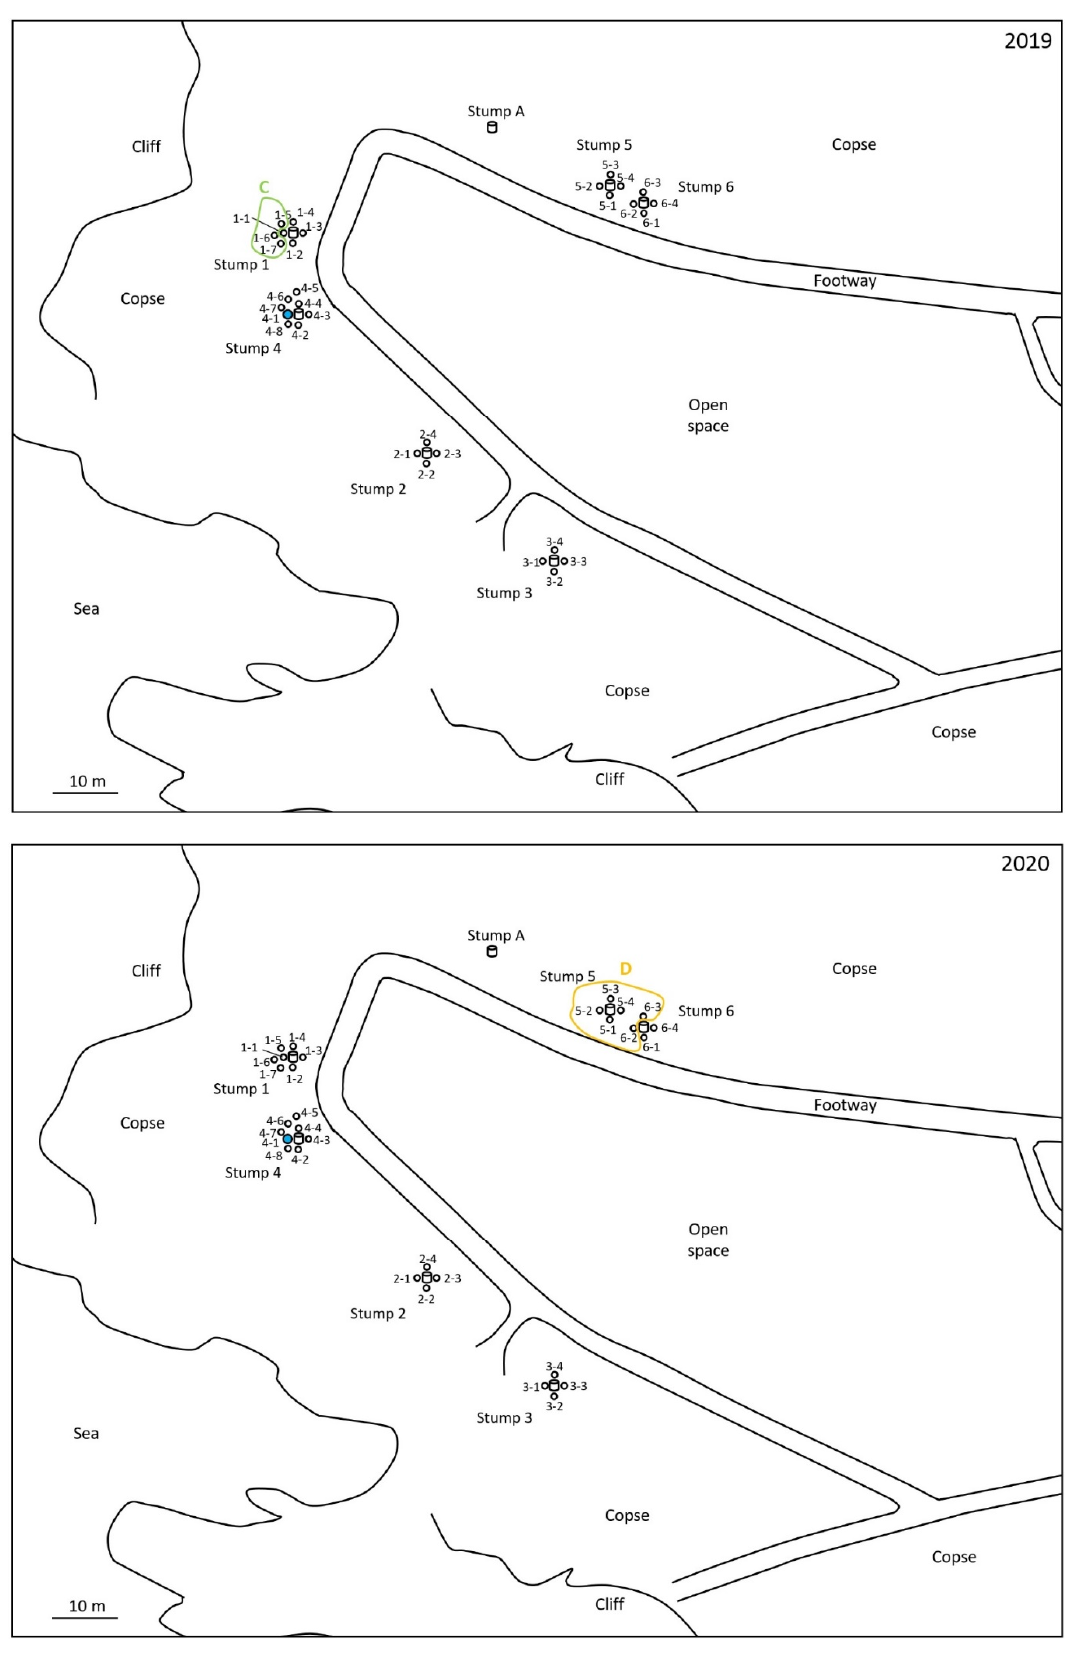
Figure 10. Location of monitoring stations occupied by Reticulitermes speratus in Isogi Park from 2016 to 2020. Stations with residing termites from the same population are encircled and labeled C and D. Station 4-1, around which discontinuous soil treatment was carried out, is highlighted in